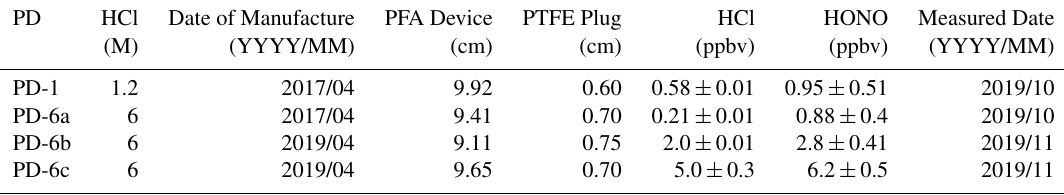
Table 1. Description of custom-made HCl permeation devices used to generate HONO. Zero-air-corrected mixing ratios of emitted HCl and generated HONO using a single NaNO 2 -coated PFA reaction device were measured with the heated Al block at 40 ◦ C in 1.1.SLPM. The variability reported for each observation represents 1 standard deviation from the mean ( n = 30 to 60 using 1min averaged